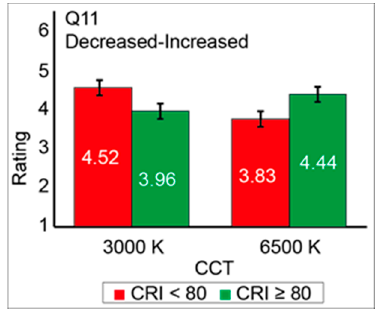
Figure 14. Interaction effects between the CRI and CCT for ( a ) satisfaction (Q9) and ( b ) satisfaction (Q10) in experiment 2.